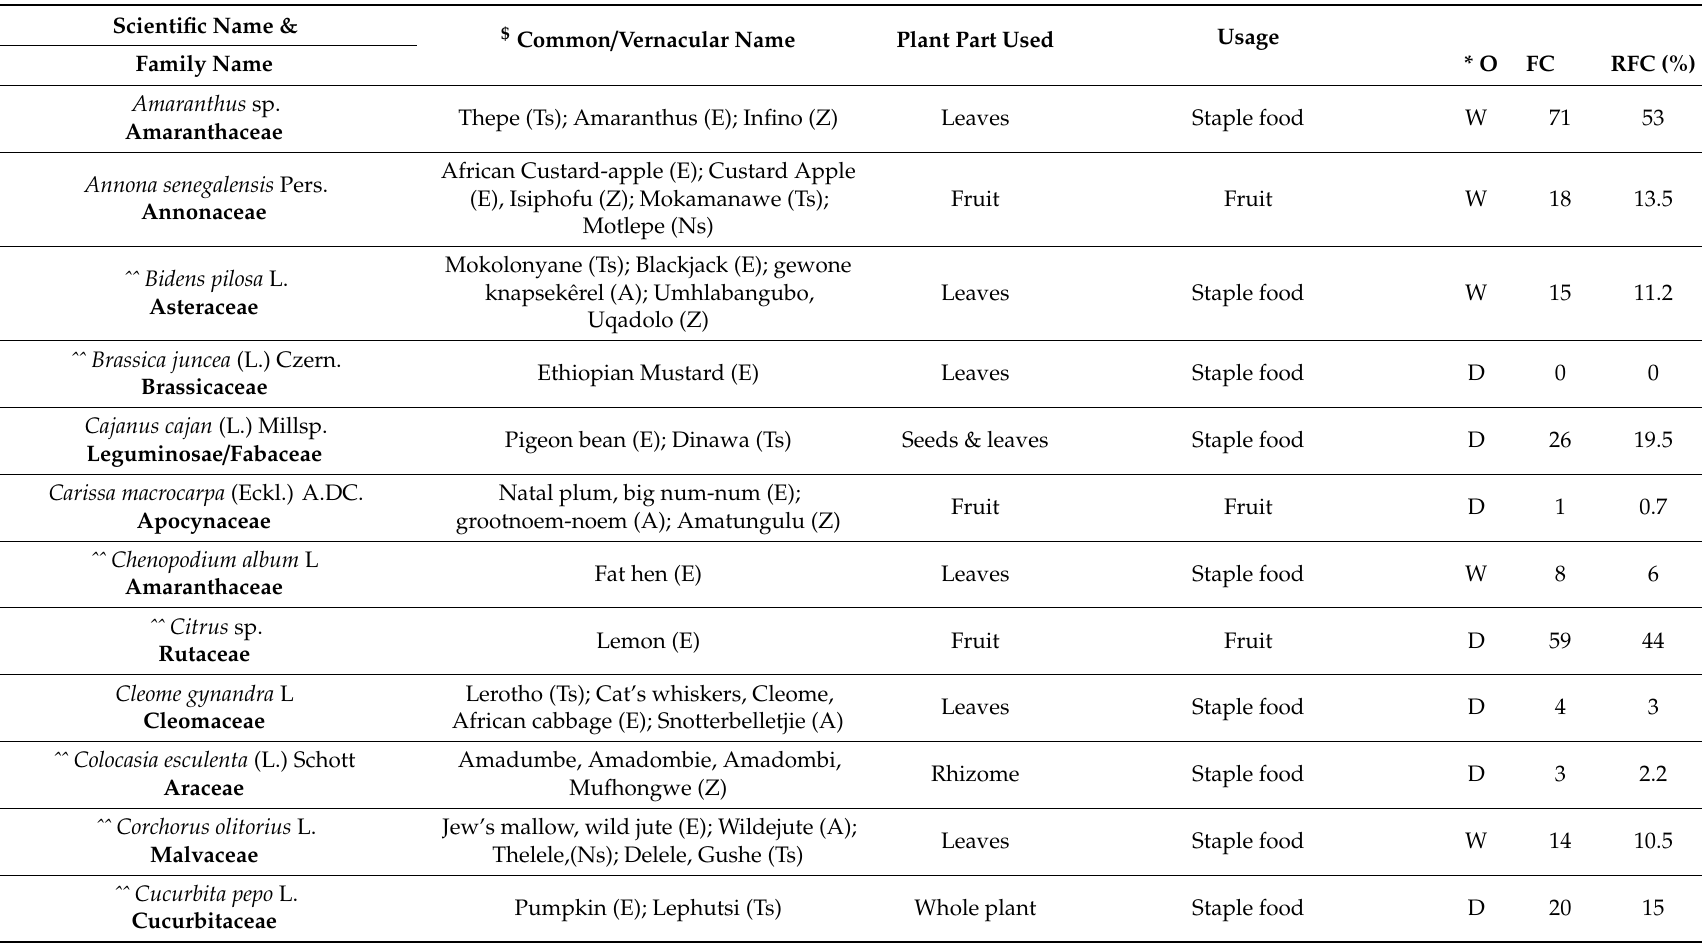
Table 2. Ethnobotanical information on indigenous and naturalized plants consumed by rural households in the North West province, South Africa. ˆˆ = naturalized plants; $ Common / vernacular name (A = Afrikaans, E = English, Z = Zulu, Ns = Northern Sotho, Ss = Southern sotho, Ts = Setswana, Tso = Xitsonga, V = VhaVenda, X = Xhosa); * O = Occurrence (W = Wild and D = Domesticated); Ethnobotanical Index used, FC = Frequency of Citation and RFC = Relative Frequency of